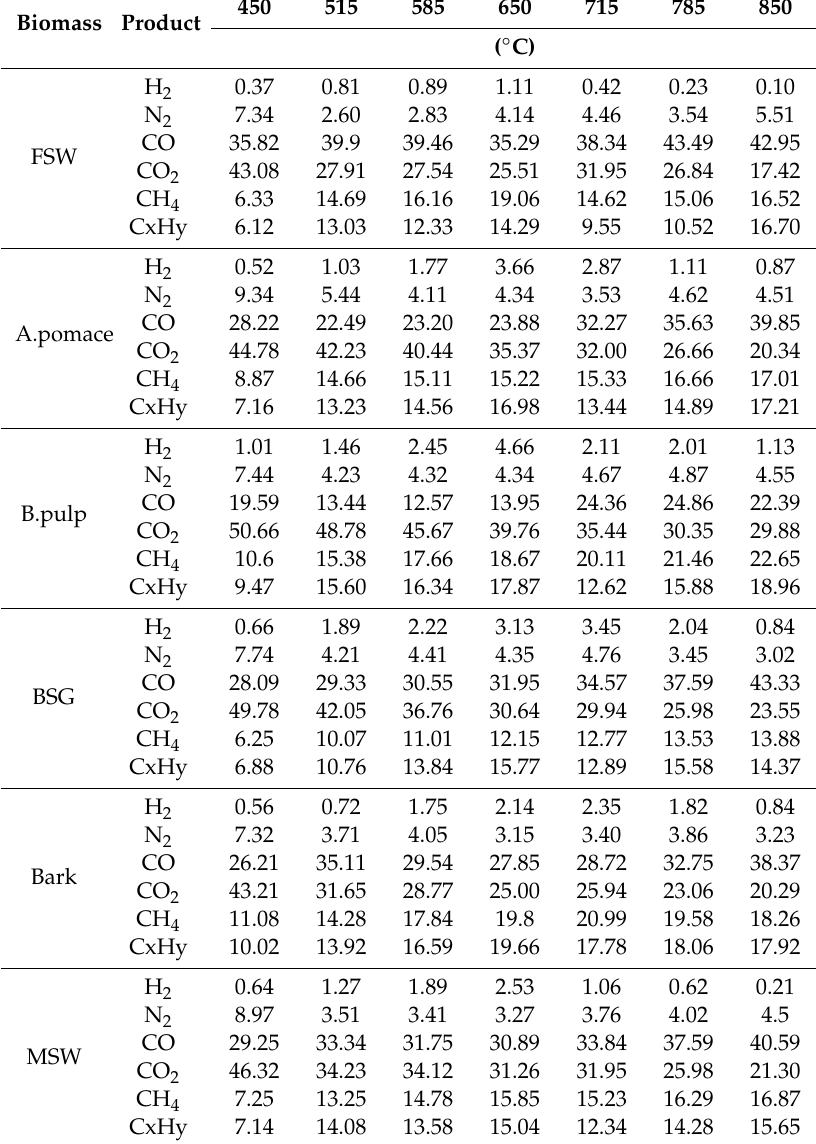
Table 3. Chemical composition of non-condensable gases produced during the pyrolysis of biomass, expressed as average values. Content of compounds expressed as relative peak area (%) of gases found in the fraction. C x H y —hydrocarbons, FSW—flavored spirits production waste (lime, grapefruit and lemon), B.pulp—beetroot pulp, A.pomace—apple pomace, BSG—brewer’s spent grain, bark, MSW—municipal solid